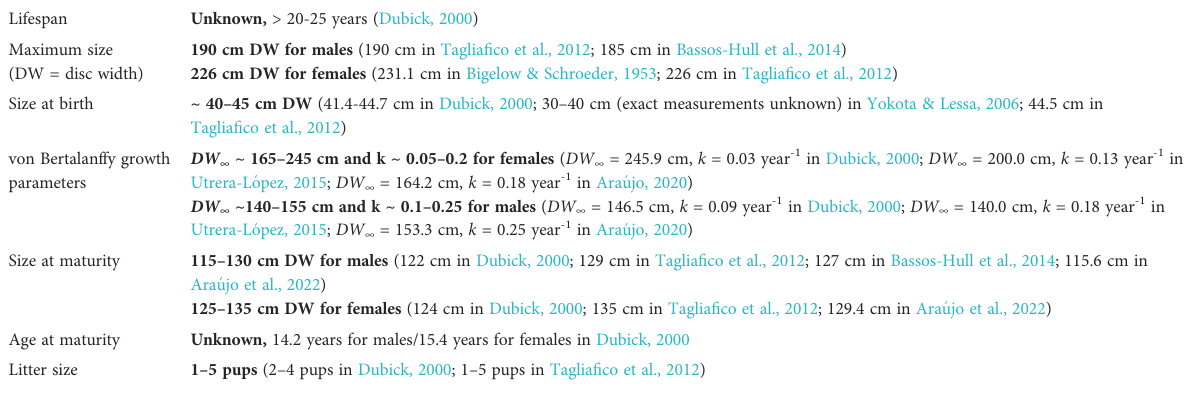
TABLE 1 Literature summary of Aetobatus narinari life history traits.